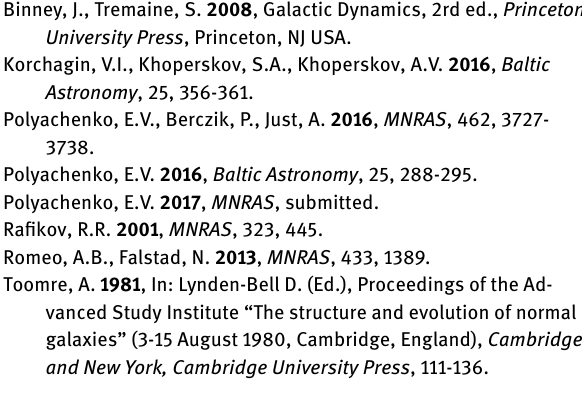
Figure 5. The profiles X ( R ) for m = 2, 3, 4.